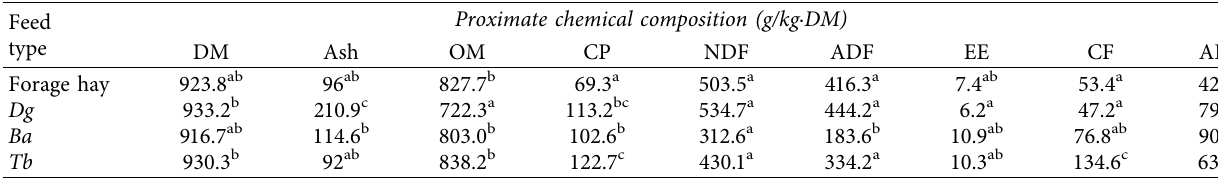
Table 3: Proximate chemical composition of the trail fodder tree leaves.